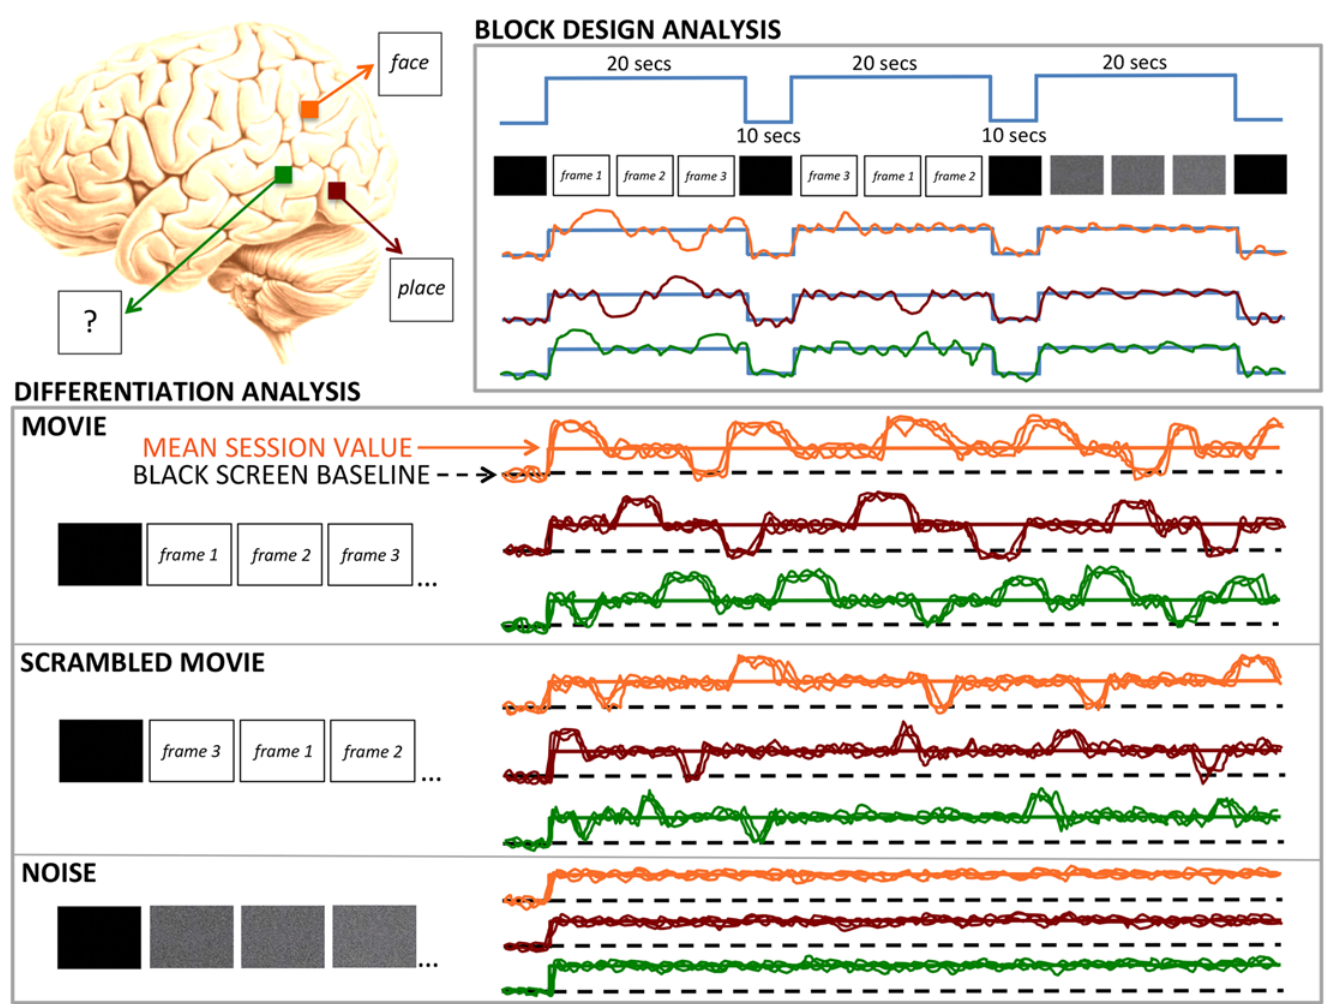
Fig 1. Experimental paradigm. Left panel: Schematic representation of a human brain with 3 representative voxels whose fMRI BOLD activity will be measured in a block design analysis and in a differentiation analysis. The red voxel is known to respond to faces, the orange voxel to places, and the green voxel has unknown selectivity. The colored traces in the right side panels represent the expected BOLD signal of these representative voxels during the fMRI experiments. Right, Top Panel: in the block design paradigm, 20 seconds sequences of movie, scrambled movie, or ‘ TV noise ’ are presented in alternation with a black screen baseline. The block design analysis is expected to reveal significant increases in the mean activity of the three pictured voxels for each of the three stimulus sequences compared to the black screen baseline. Bottom Panel: in the differentiation analysis paradigm, a 4 min sequence of movie, scrambled movie or ‘ TV noise ’ is presented to the subjects, each sequence repeated 30 times across different scanning sessions (only 3 of these repetitions are depicted, corresponding to 3 BOLD activity traces per voxel). In all three conditions, we expect an overall activation with respect to the black screen baseline similar to that in the block design paradigm. However, unlike the block design analysis, the differentiation analysis focuses on systematic time- locked increases or decreases in activity with respect to: i) each voxel ’ s the black screen baseline (dashed black line); ii) each voxel ’ s mean activity during the 4 min sequence. Movie sequence: for each voxel, we expect systematic time-locked increases and decreases of activity across the session (neurophysiological differentiation over time); moreover, we expect different voxels to show different patterns of systematic activations/deactivations in response to different movie frames (neurophysiological differentiation over space). Altogether, high neurophysiological differentiation in space and time (many different spatio-temporal patterns) is expected to go along high phenomenological differentiation (many different experiences). Scrambled movie sequence: we expect intermediate levels of neurophysiological differentiation, corresponding to intermediate levels of phenomenological differentiation. TV noise sequence: we expect no or minimal systematic time-locked incease or decreases in activity. Low neurophysiological differentiation (a single, unchanging pattern of activation/deactivation) corresponds to low phenomenological differentiation (a single, unchanging experience of ‘ TV noise ’ ). Spontaneous fluctuations in BOLD activity from scan to scan are also expected in the ‘ TV noise ’ session, but they will not be time locked to specific ‘ TV noise ’ frames, which cortical regions treat as equivalent. For copyright reasons, all movie pictures were replaced in Figures by numbered blank frames representing their order of appearance in the movie.